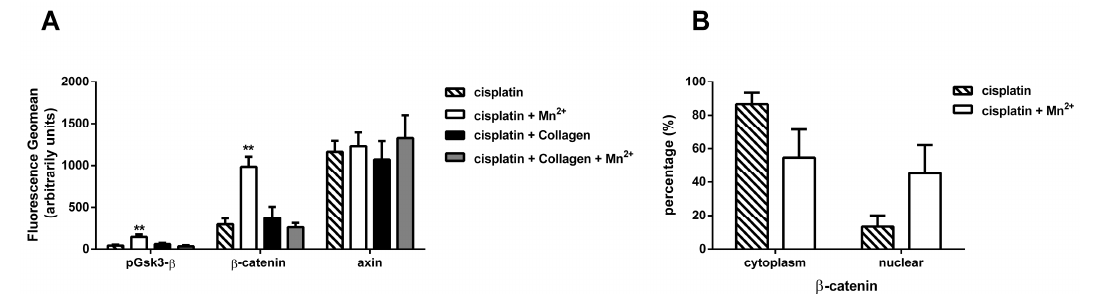
Figure 6. Wnt signalling. Protein levels were accessed by FACS after 72 h of incubation with cisplatin (IC 50 ). MV3 cells were treated as indicated above. Cells were collected after 72 h of cisplatin incubation and analysed. ( A ) Total protein level of wnt signalling related proteins. Data show a significant increase in pGsk3- β as well as β -catenin indicating active wnt signalling. Note that there is no apparent deregulation of axin excluding the possibility of canonical activation through frizzled. Presenting geomean of at least n = 3 (SEM); asterisks indicate statistical significance compared to cells treated exclusively with cisplatin: * p < 0.05; ** p < 0.01; *** p < 0.001. ( B ) β -catenin localisation was accessed by FACS only for cisplatin treated cells and manganese-cisplatin combination, based on the results of Figure 6A. Total and partial cytoplasmic fraction of β -catenin was measured, from which